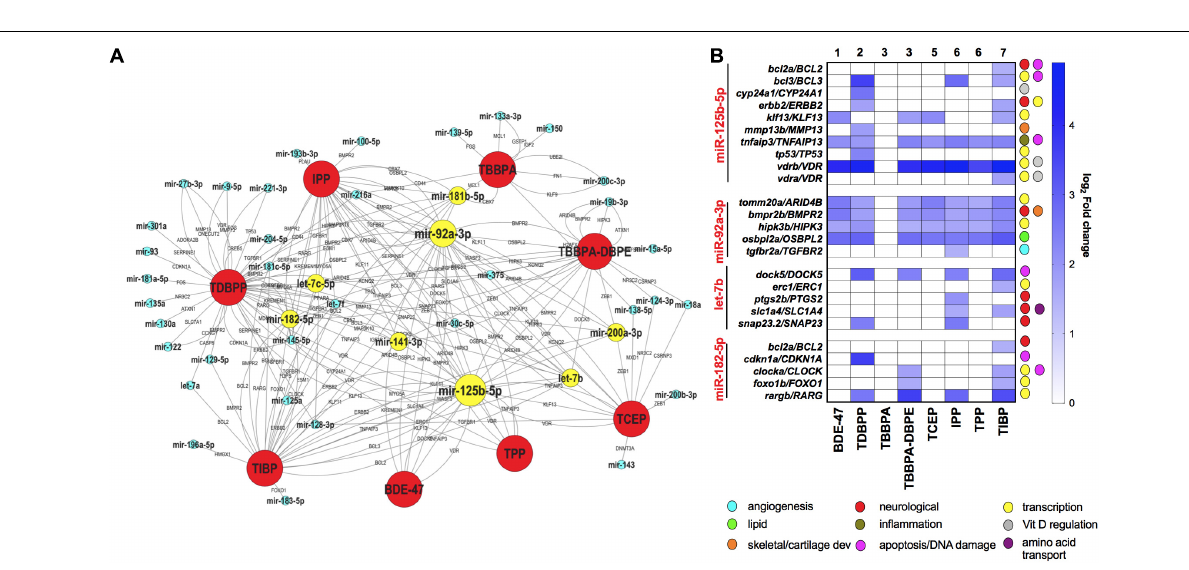
Frontiers in Cell and Developmental Biology |